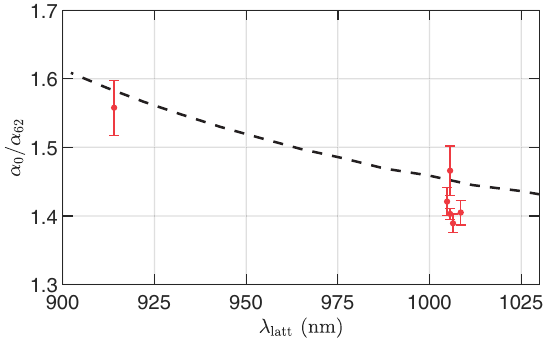
FIG. 7. The baseline ac polarizability ratio of the clock states in this study ( α 0 = α 62 ) at various trap laser wavelengths. Red circles are experimental measurements. The black dotted line is the theory calculation. X → ð 1 Þ 1 resonances are excluded from this u plot, but are included in the calculation. Error bars represent 1 σ statistical